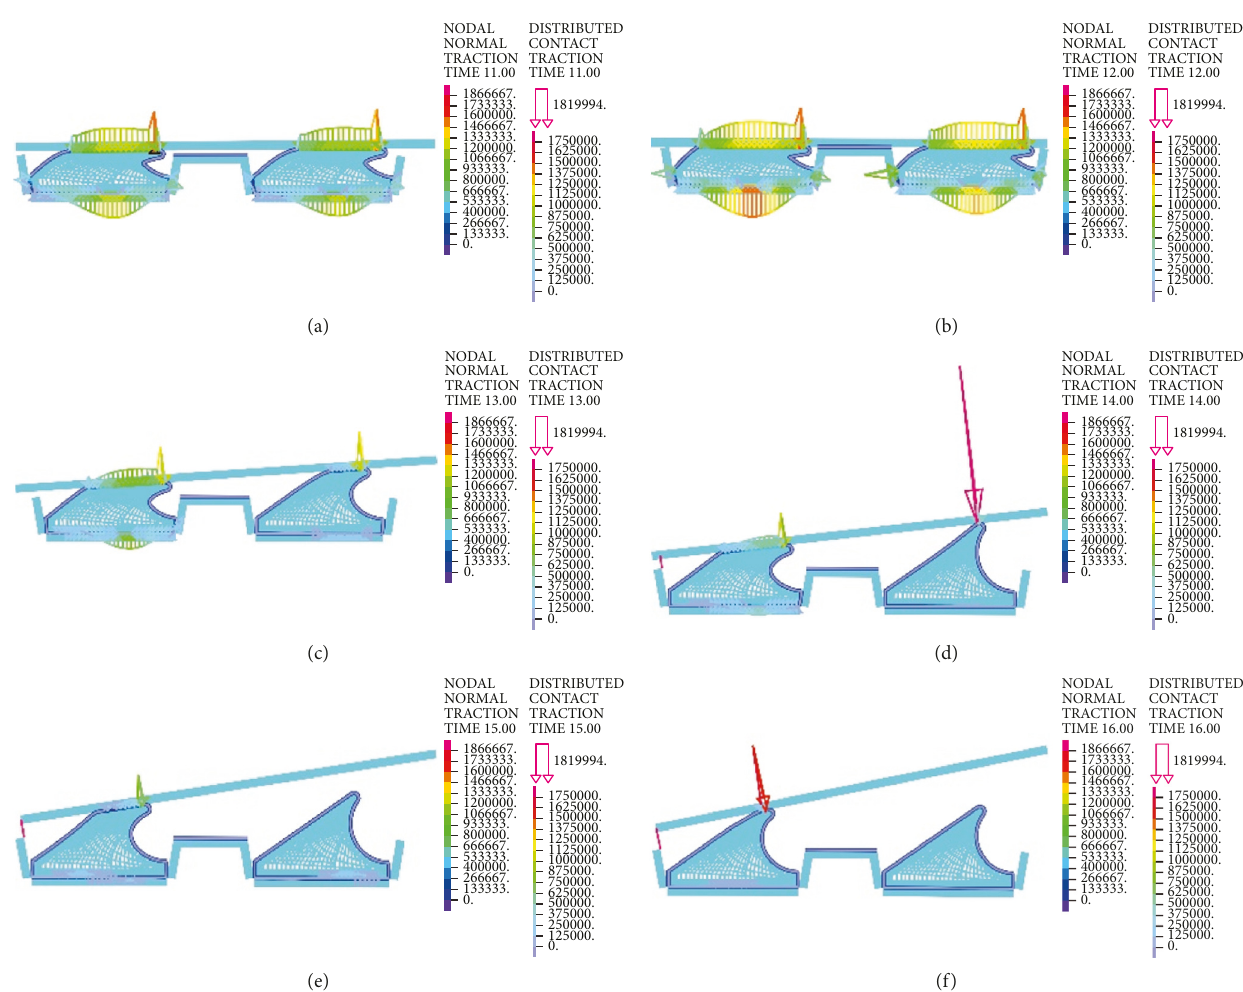
Figure 15: Contact stress distribution of the rubber rings before optimizing during clockwise rotation. (a) Deflection 0.2 ° . (b) Deflection 0.4 ° . (c) Deflection 0.6 ° . (d) Deflection 0.8 ° . (e) Deflection 1.0 ° . (f) Deflection 1.2 °